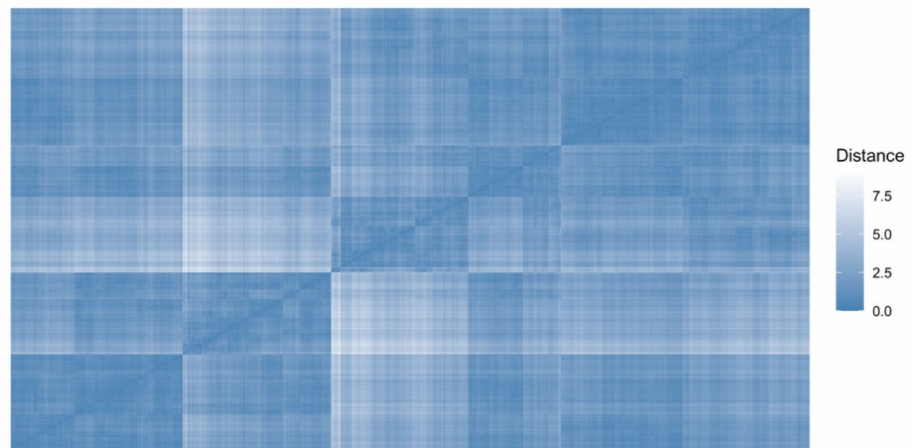
Figure 4. Image matrix created by the VAT method, in order to visually inspect the clustering tendency of data. Distances (dissimilarities) among unitless rainstorms are unitless. The rainstorms that belong to the same cluster are displayed in successive order.